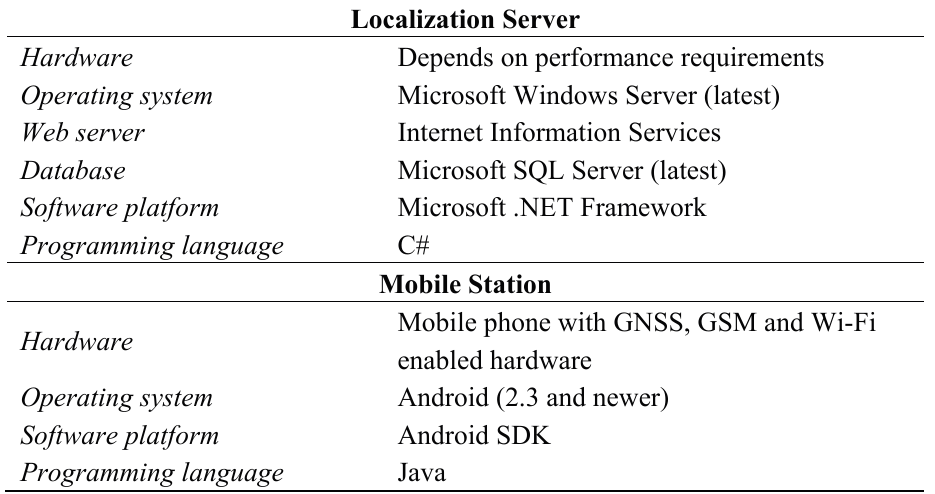
Table 2. Technologies of localization server and mobile